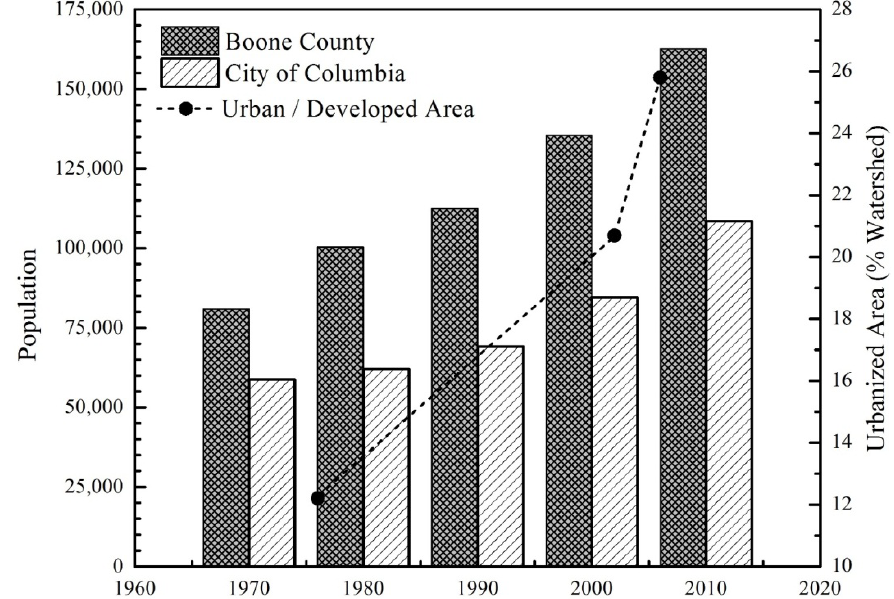
Figure 1. Population growth from 1960 to 2010 in Boone County and the City of Columbia, Missouri, USA, and associated increase of urbanized area.